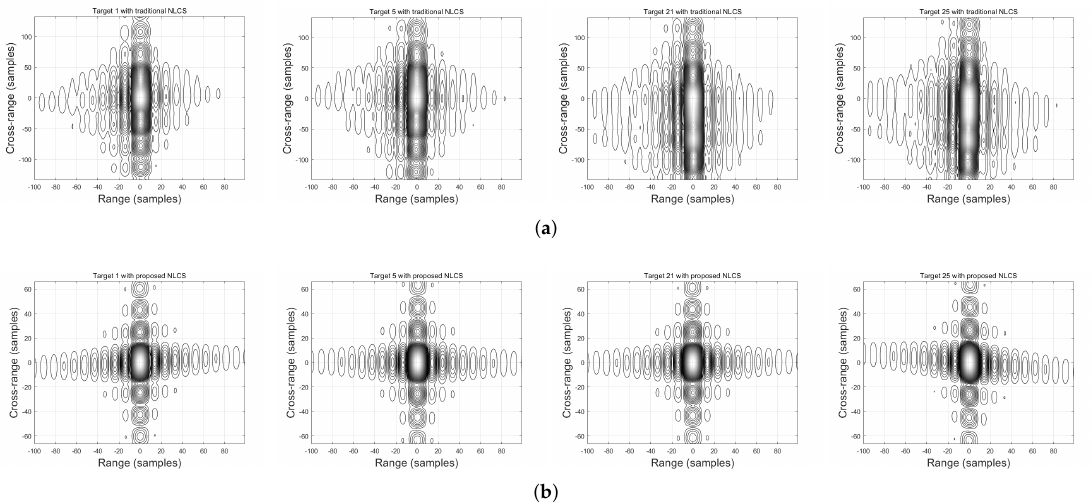
Figure 12. Simulation SAR data processed with different imaging algorithms. The subimages from left to right in every row correspond to target 1, target 5, target 21 and target 25, respectively. ( a ) Traditional NLCS algorithm in [41]. ( b ) Proposed algorithm.